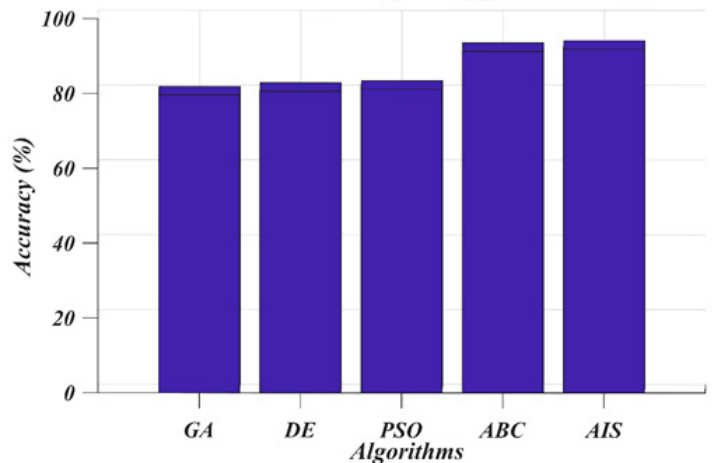
Figure 10. Accuracy Evaluation for Congressional Voting Records.